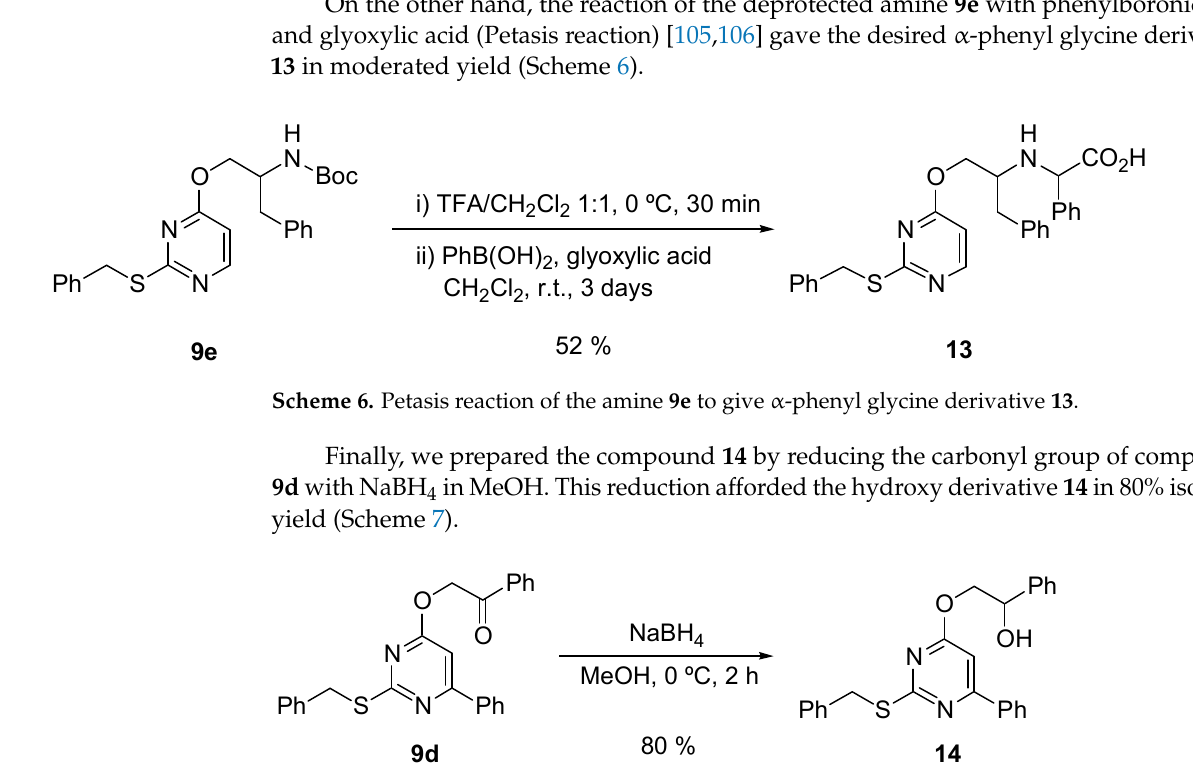
Table 6. Experimental MIC of conventional drugs against MTBC.